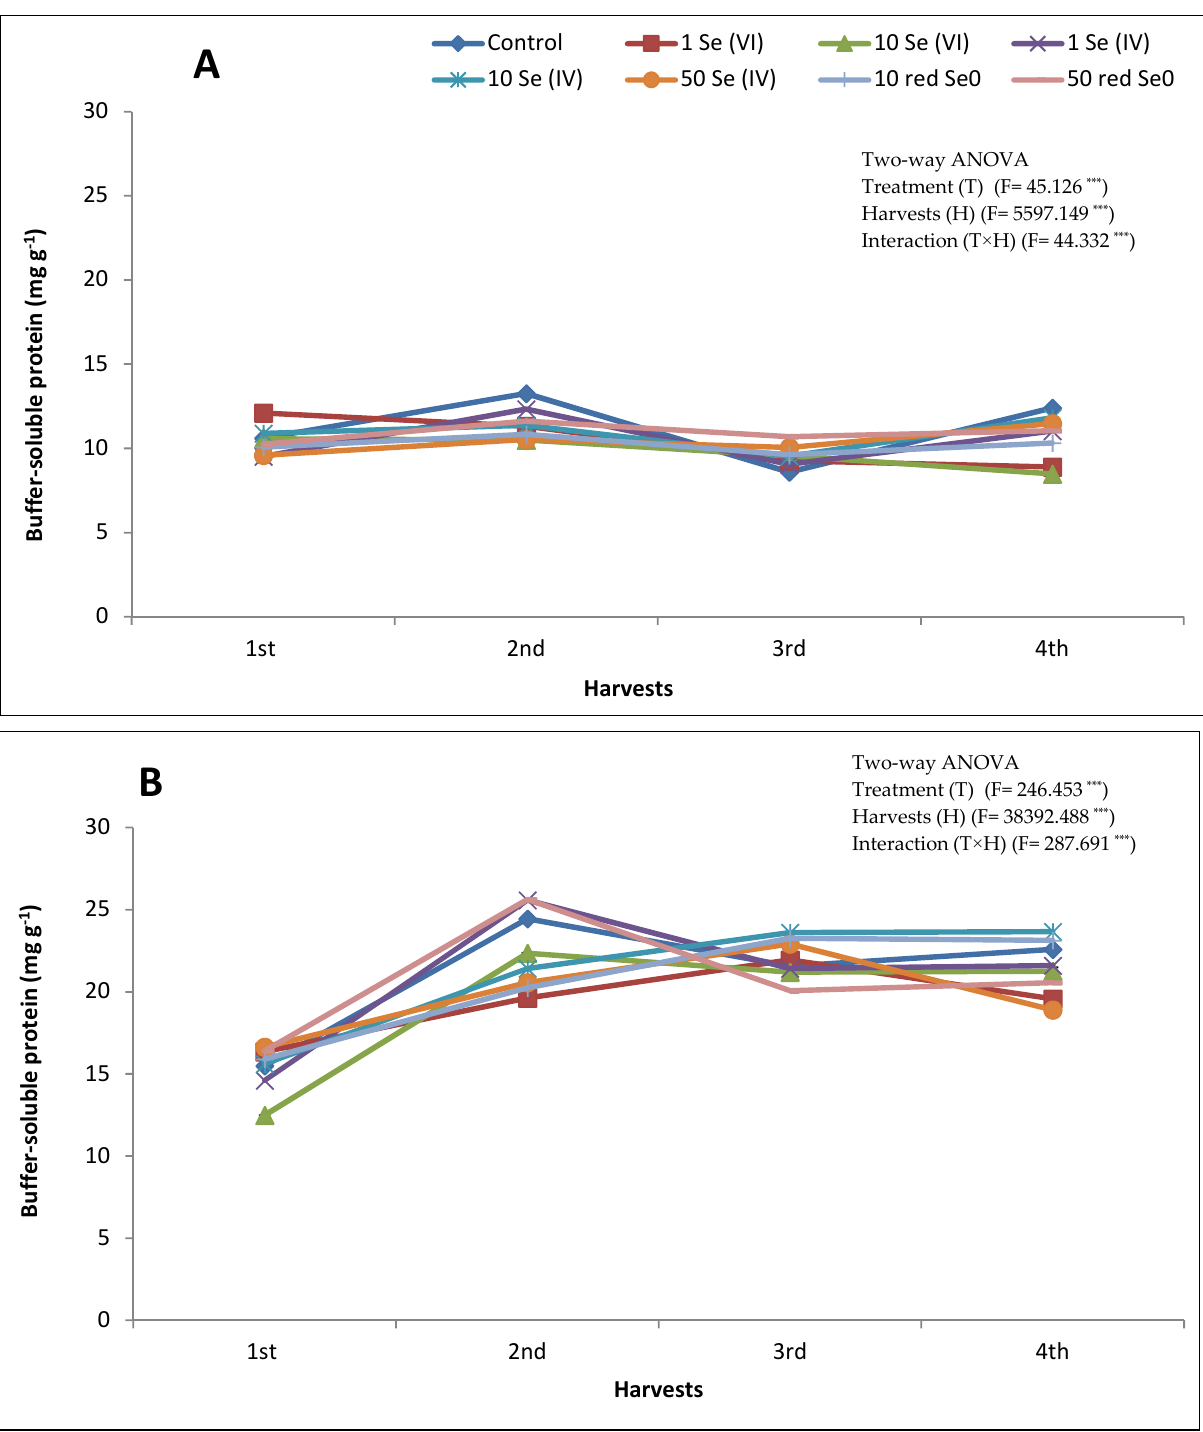
Figure 3. Buffer-soluble protein content in ( A ) stem and ( B ) leaves of alfalfa fertilized with different Se forms (i.e., Se (VI), Se (IV) and red Se 0 ) at different concentrations (1, 10, and 50 mg kg −1 for ionic forms and 10 and 50 mg L −1 for red Se 0 ) within four consecutive harvests with 30-day intervals. Alfalfa plants that received 50 mg kg −1 Se (VI) died two weeks after seed germination. Data are means ± SD ( n = 6). *** significant according to Tukey’s test ( p ≤ 0.001)